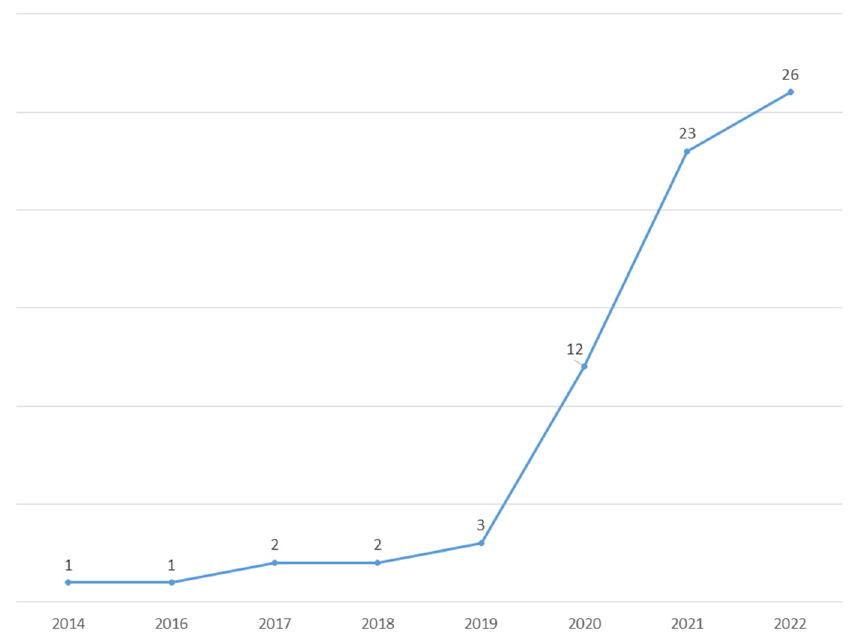
Figure 3. The number of articles included in this review by the year of publication.